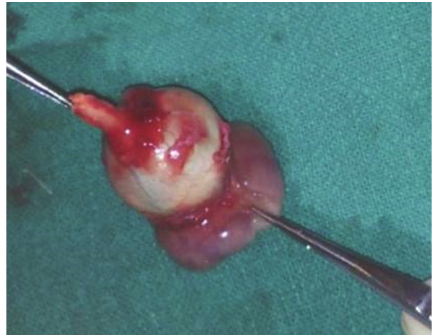
Figure 6: Enucleated specimen of the left eye with normal optic nerve stump.